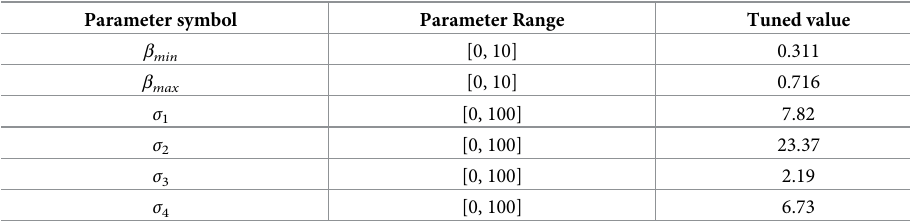
Table 2. Parameter selection of the HSF for the ADoS-STR